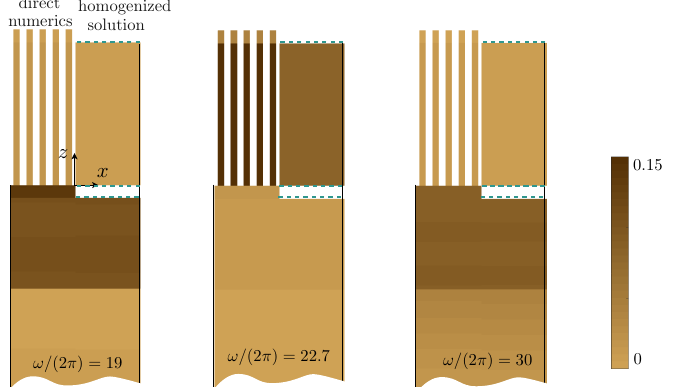
Figure 11. Surface densities of energy in the actual problem (computed numerically) and given by the homogenized solution at ω / ( 2 π ) = 19 (corresponding to the resonance of the Love type with R = the energy is stored in the layer and in the bottom layer), at ω / ( 2 π ) = 22.7 (resonance with R = of the SPP type; the energy is stored in the plate), and at ω / ( 2 π ) , which is a standard case ( R the energy is